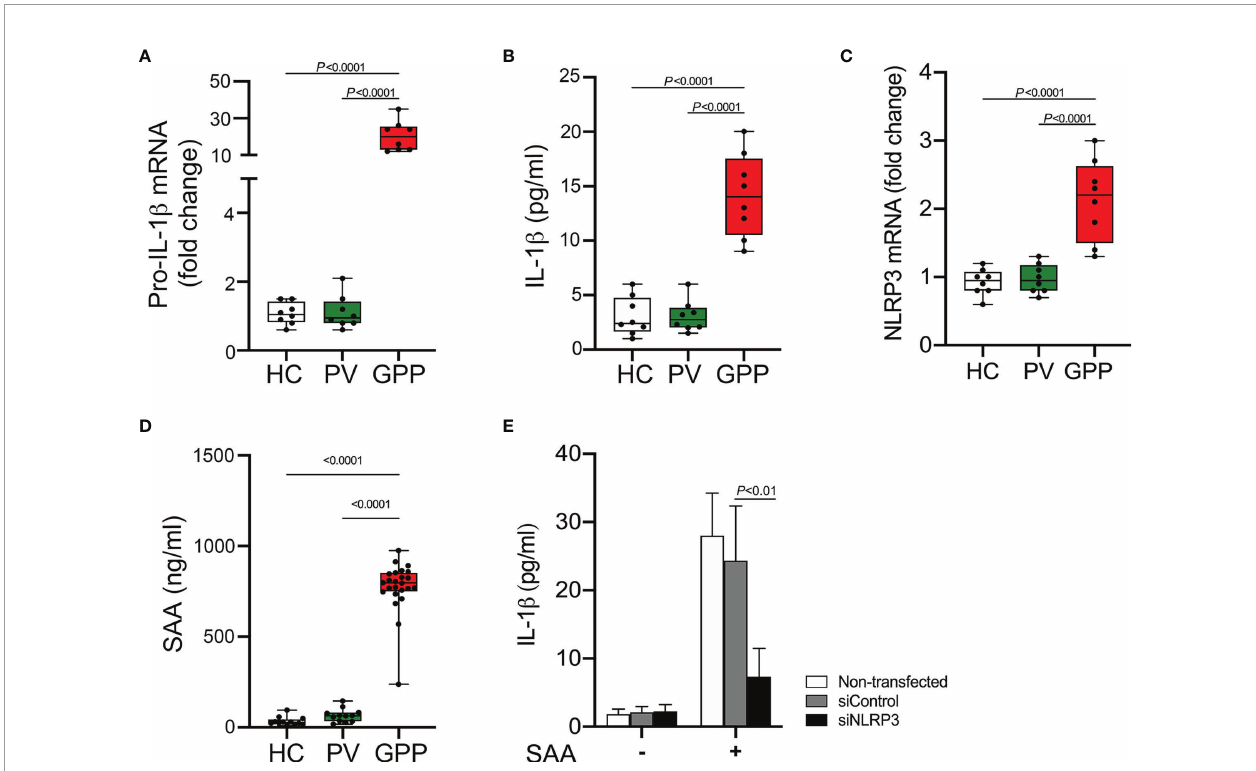
FIGURE 1 | Production of IL-1 b from blood monocytes induced by SAA. (A) Blood monocytes were isolated from GPP, PV and HC. Pro-IL-1 b mRNA levels were measured by real-time RT-PCR. (B) Monocytes from GPP (n = 8), PV (n = 8) and HC (n = 8) were cultured ex vivo for 24 h, and then IL-1 b in the supernatants was quanti fi ed by ELISA. (C) NLRP3 mRNA fold change in monocytes from GPP (n = 8), PV (n = 8) and HC (n = 8) were examined using real-time RT-PCR. (D) Serum levels of SAA in patients with GPP (n = 24), PV (n = 12), and HC (n = 12). (E) Healthy monocytes were transfected with siRNA targeting NLRP3 (siNLRP3) or a non- speci fi c siRNA (siControl), and then cultured with SAA (10 m g/ml) for 24 h The supernatants were tested with IL-1 b ELISA. Data are presented as mean ± SD, and are assessed by One-way ANOVA and Dunnett ’ s post hoc